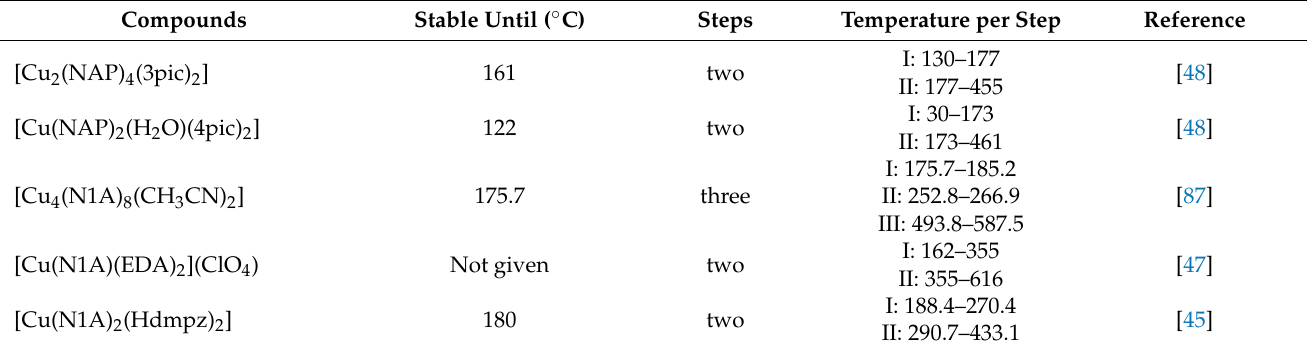
Table 6. Data regarding the thermal behavior and stability of reported